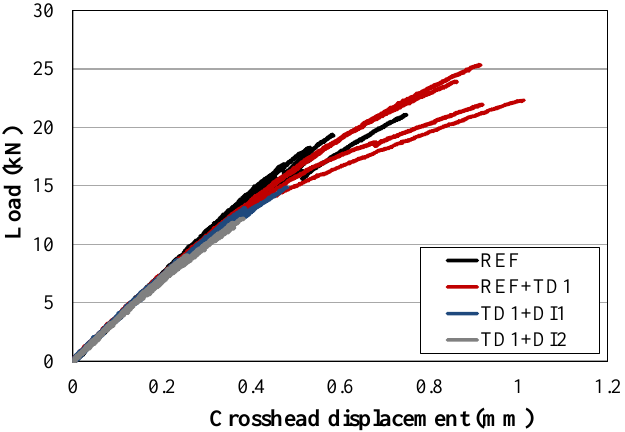
Figure 5. Load-displacement curves for reference and contaminated scarfed adhesive joints.